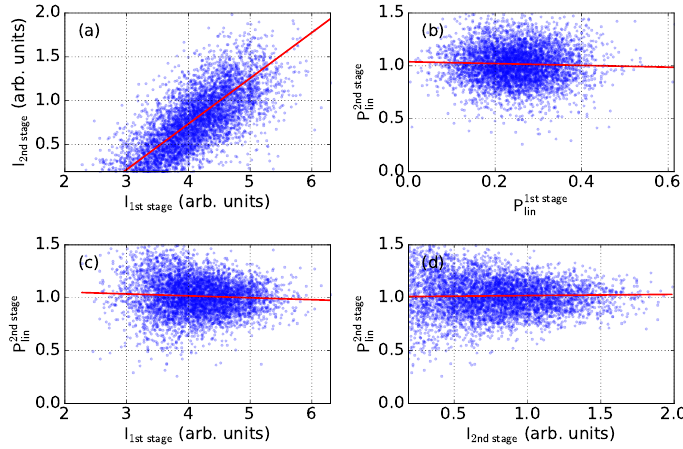
Figure 6. Correlation between first and second stage emission: intensity inside the eTOF polarimeter of the second stage in function of the first stage ( a ); degree of linear polarization of the second stage as a function of the first stage ( b ); and degree of linear polarization of the second stage in function of the intensity of the first ( c ) and the second ( d ) stage. Same data as in Figure 5. ( blue : experimental data, red : linear regression).